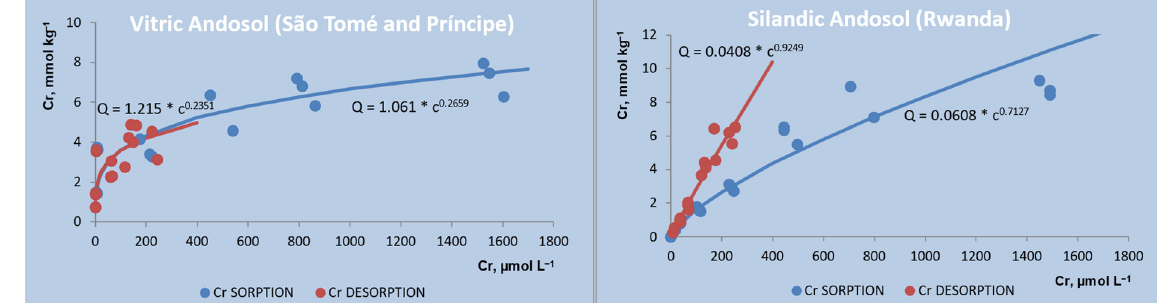
Figure 7. Cr sorption and desorption isotherms (sorbed Cr (mmol kg − 1 ) vs. Cr concentration in the equilibrium solution (µmol L − 1 )) fitted to the Freundlich model.